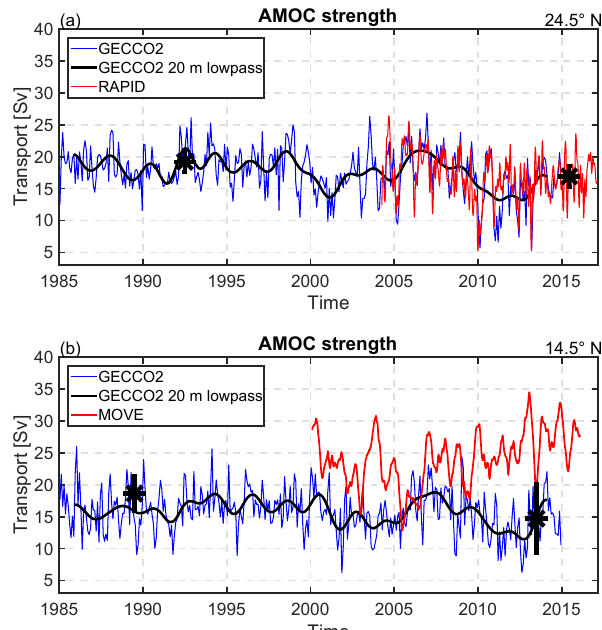
Figure 15. Meridional overturning strength at (a) 24.5 ◦ N and (b) 14.5 ◦ N, calculated from GECCO2 (blue), RAPID (red in a ), MOVE (red in b ), and the inverse method (black stars with error bars for the respective years). The thick black line marks the 20- month low-passed time series of the GECCO2 meridional overturn- ing strength. Note that the MOVE time series represents the south- ward transport in the NADW layer (1200 to 4950m) in the western Atlantic basin, and that the sign of the MOVE time series is artifi- cially reversed to ease the